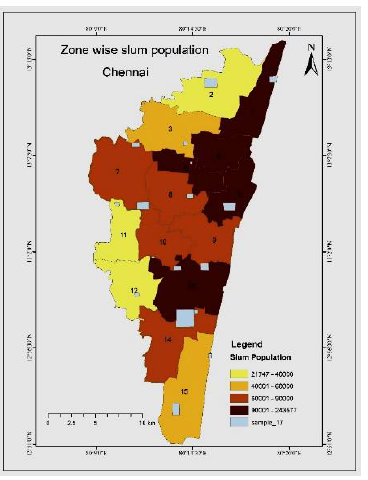
Table 4. Distribution of slums at regional level Being elongated in shape, Chennai is divided into three regions namely Northern Chennai, Central Chennai and South Chennai. The number of wards have slum population is high in northern Chennai compared to other regions. Presence of industrial and commercial activities along with more open space during 2000s also reasons for major slum growth and slum expansion in this region.